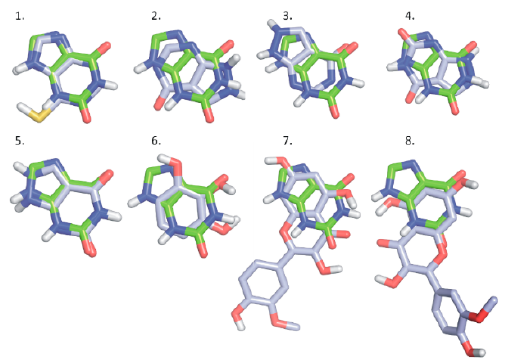
Figure 10. A series of docked ligands (light blue) shown together with the native ligand xanthine (green, used as reference): 6-MP (1; Rank 1); APU (2; Rank 1), APU (3; Rank 2); oxipurinol (4, Rank 1), oxipurinol (5, Rank 2), PYR (6; Rank 1), IR (7; Rank 1), and IR (8, Rank 2).